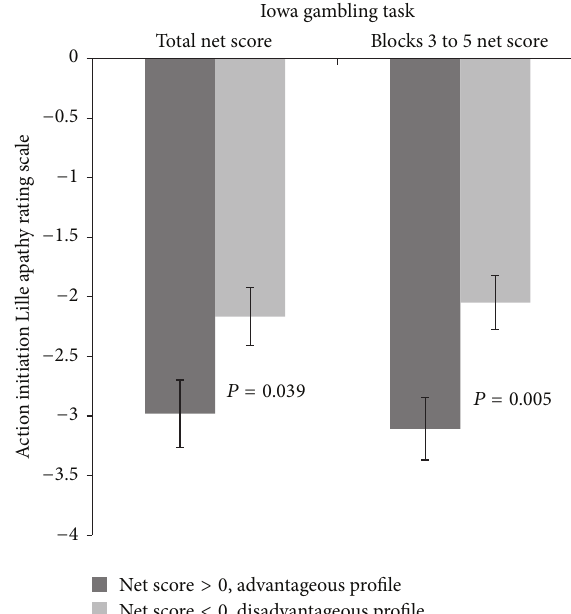
Figure 2: Lille Rating Scale’s action initiation score for participants ( 𝑛 = 60 ) with advantageous and disadvantageous profile on the total net score and on the net score for blocks 3 to 5 (trials 41–100). Mean ( ± SEM) are